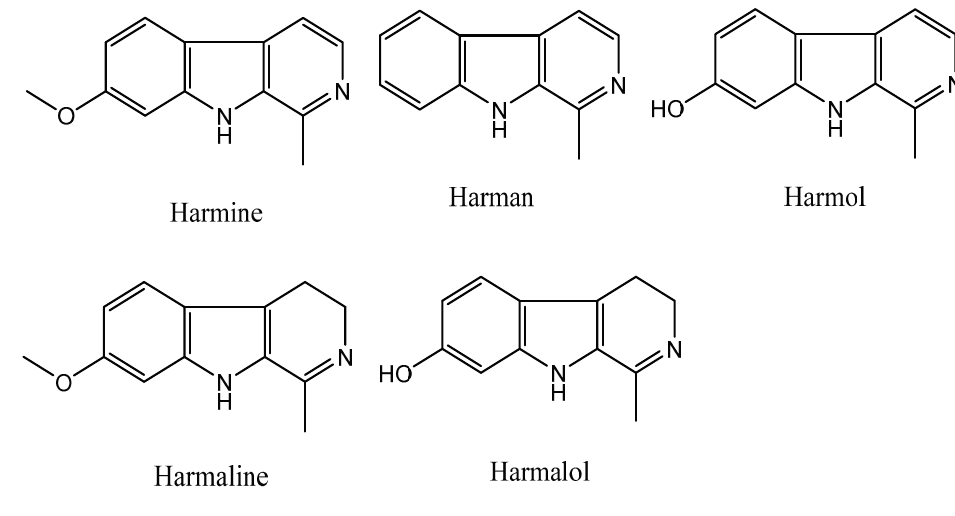
Figure 1. Chemical structures of β -carboline